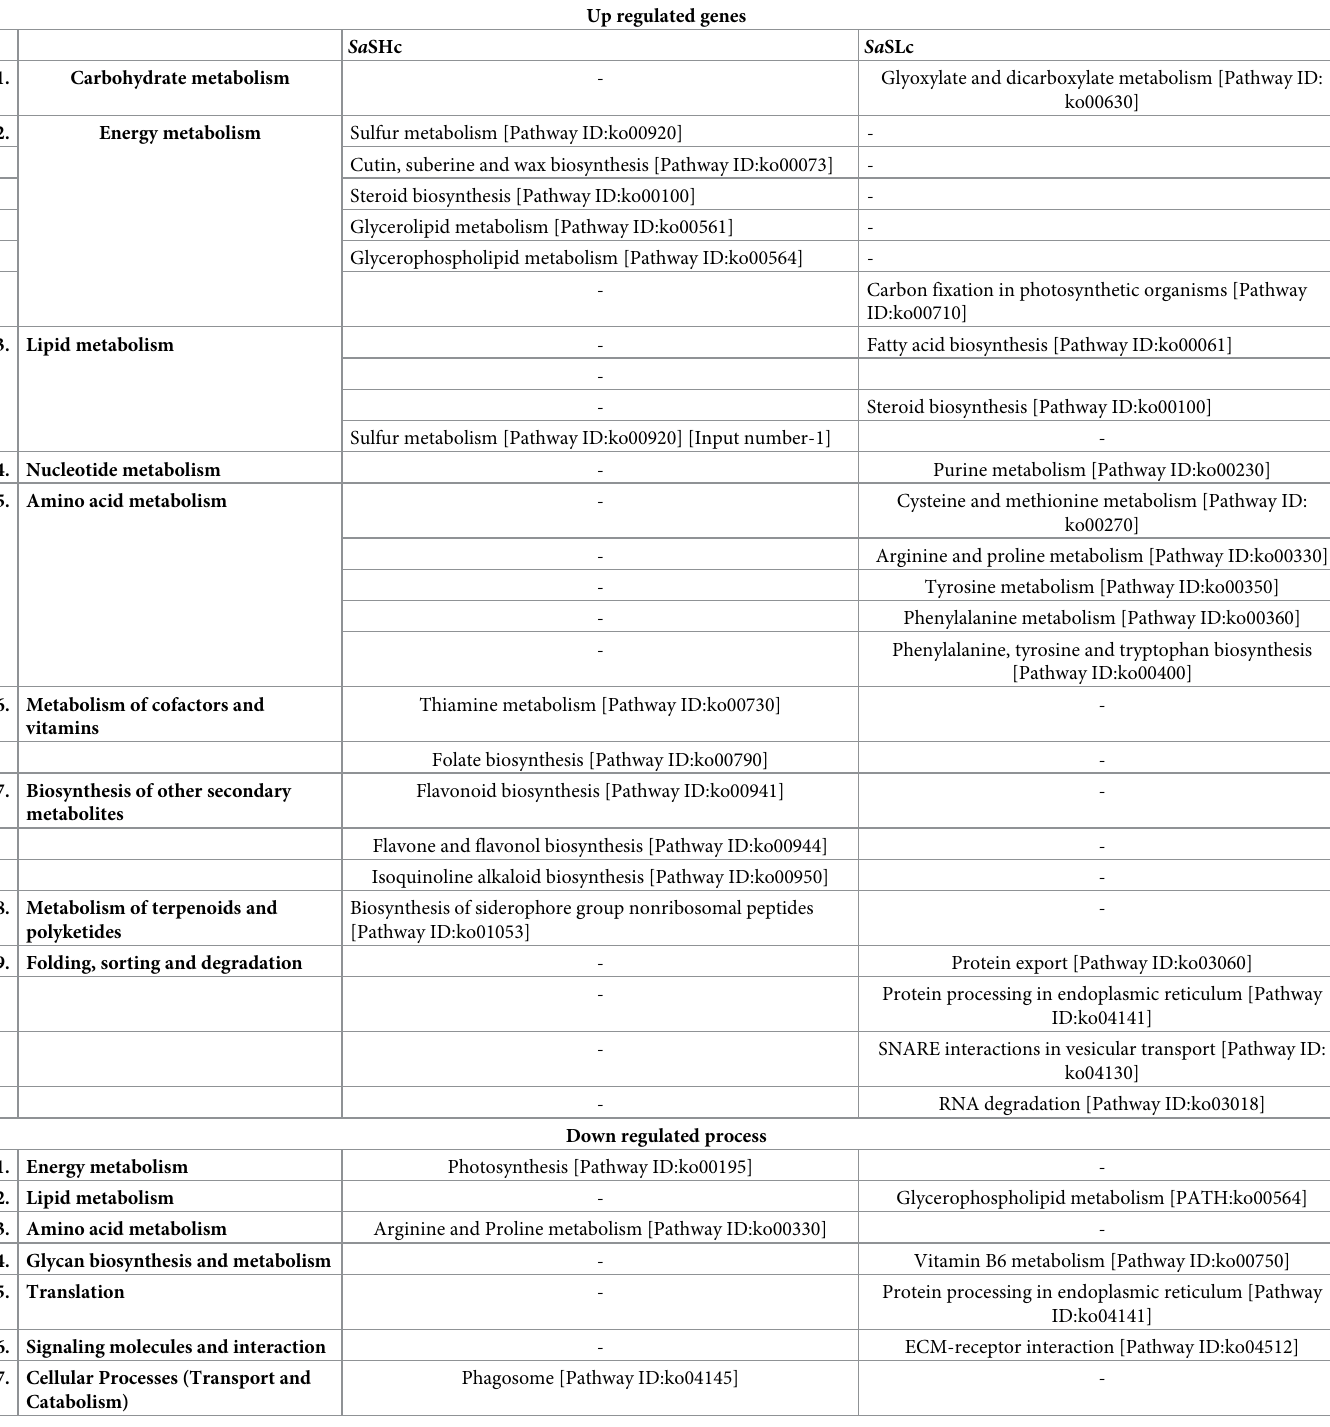
Table 6. Total biological process associated with differentially expresses genes (DEGs) in high and low oil yielding sandalwood ( S . album